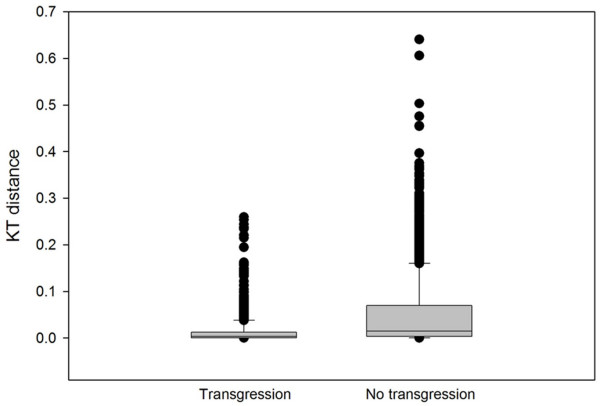
Box plots demonstrate a relationship between MTOM and transgression. Crosses that produce transgressive F2 are between parental species with less difference in starting KT (a proxy for MTOM) than crosses that do not produce transgressive F2 (t-test, p < 0.001). The bar is the median value, the box is the 25th-75th percentile, whiskers are the 10th and 90th percentiles and the dots are outliers beyond the 5th and 95th percentiles.